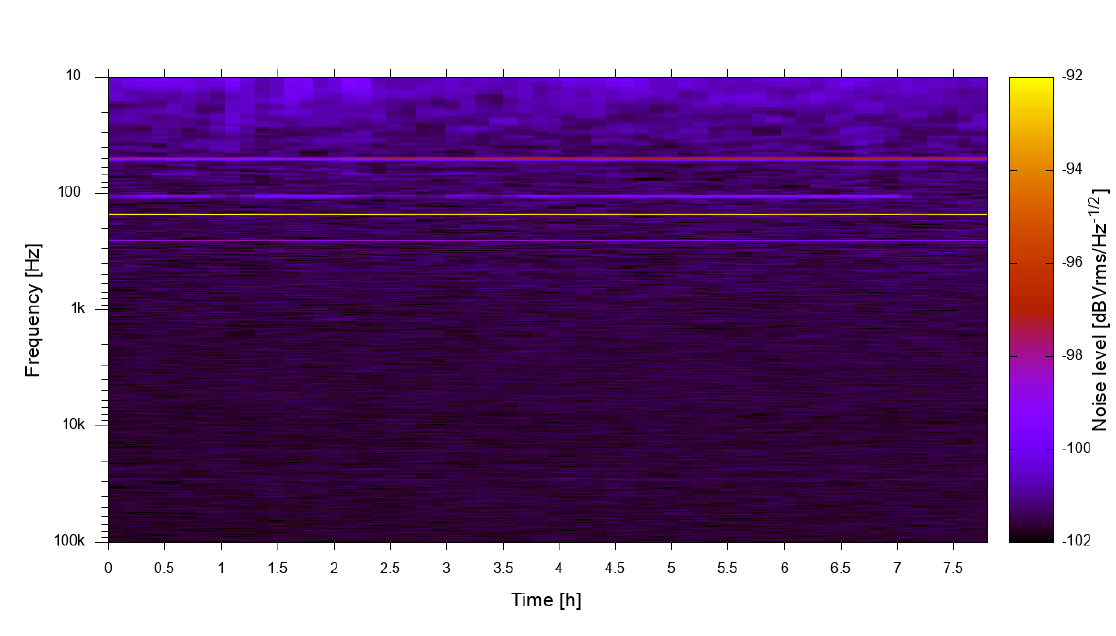
Figure 4. Spectrogram of the squeezing level in the frequency ranges from 10Hz to 100kHz. The spectrum analyzer was remotely controlled to record 70 consecutive squeezing spectra. For each measurement, the following five FFT-windows (number of averages) were chosen: 10–400Hz (200), 400Hz–1.6kHz (400), 1.6–6.8kHz (800), 6.8–25.2kHz (800), 25.2–102.4kHz (800). Each measurement takes approximately 6.5 min yielding a total duration of 7.8 h accumulated squeezing data. For these measurements, the 532nm pump power was slightly increased, resulting in a maximum squeezing level of 9.3dB. This squeezing level is stable within ± 0.1dB. A small degradation of the squeezing level is visible at frequencies below 100Hz. The pronounced horizontal lines correspond to spikes in the squeezing spectrum at 50,150 and 250Hz due to electronic